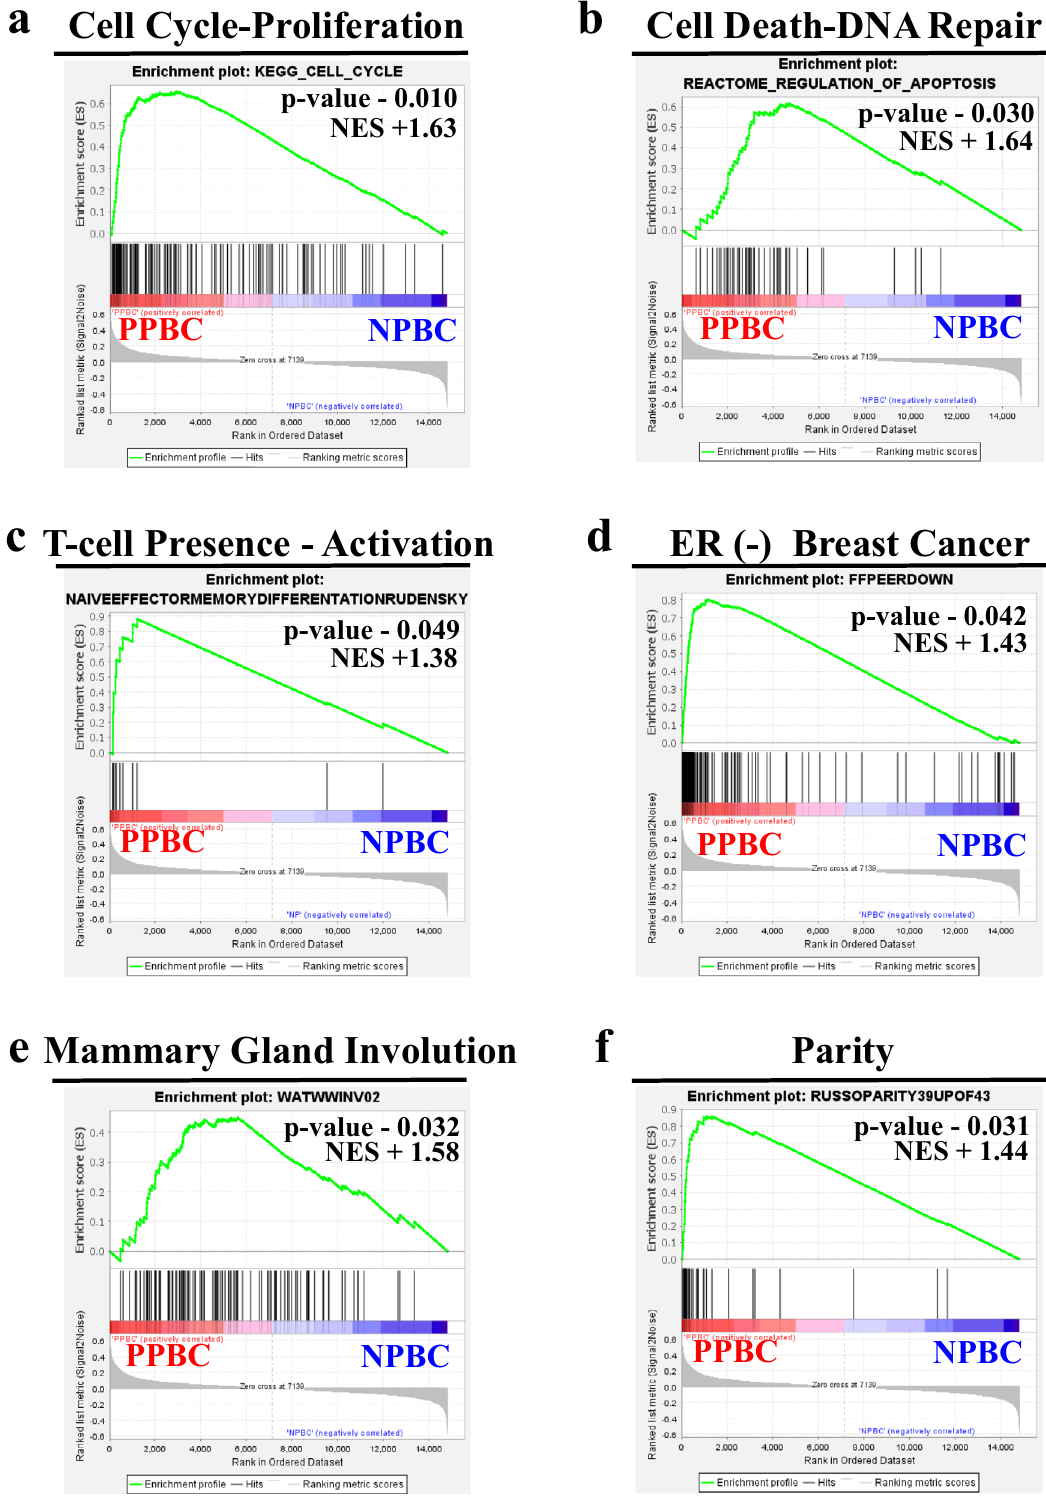
Fig. 1c), the ER-negative breast cancer signature (Supplementary Fig. 1d) nor the proliferation signatures (Supplementary Fig. 1e, f) were upregulated in normal postpartum tissue, whereas these gene signatures were upregulated in PPBC samples. One inter- pretation of these data is that PPBC is a convergence between breast cancer and the reproductive